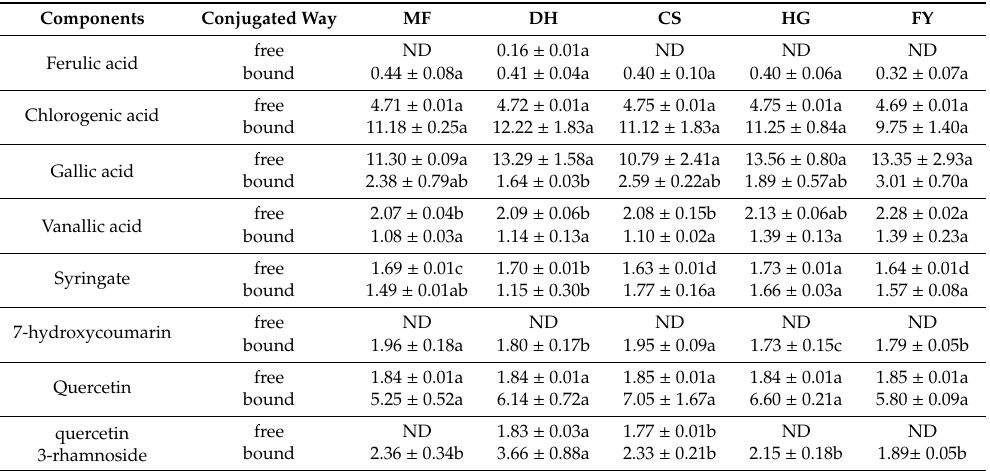
Table 1. Phytochemical profiles of five di ff erent chestnut